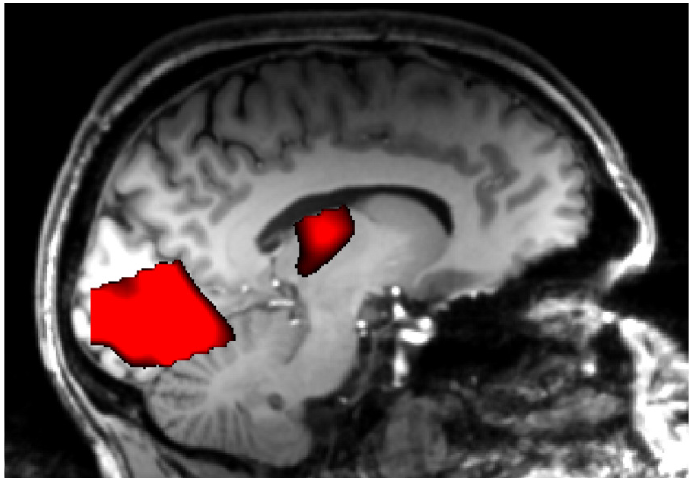
Figure 5. Brain regions that are activated by the different, ultra-short presentation durations using a linear regressor comprising the presentation durations of 1, 3, 5, 7, 9, and 11 ms. The sagittal map shows significant BOLD-signal increases projected onto the